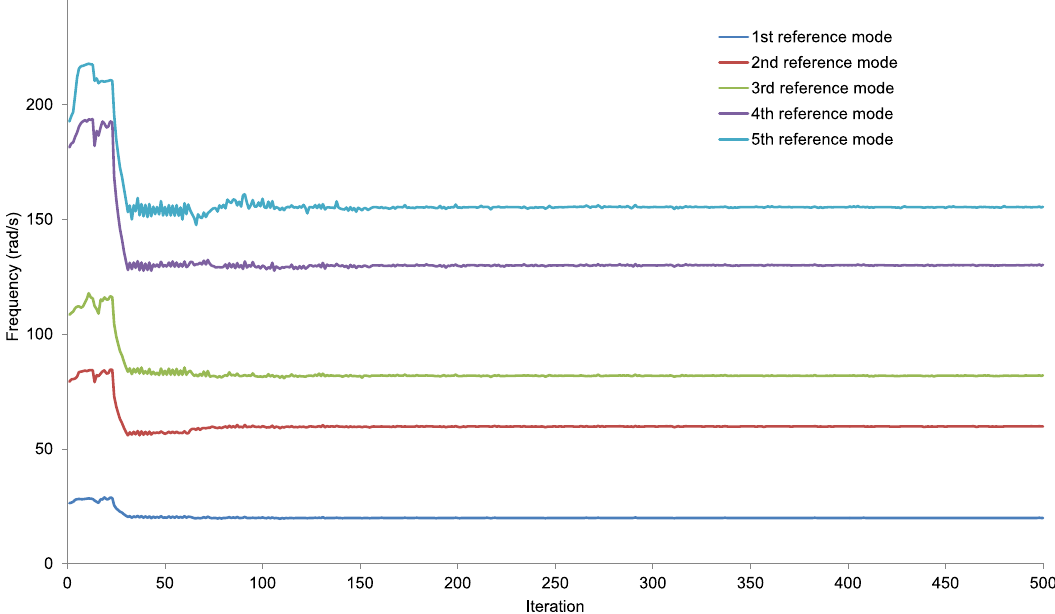
Fig. 5. Evolution of the natural frequencies of the current model sorted according the best corresponding reference modes. The frequencies of the 4th and 5th modes nearly intersect around iteration 40, however their values do not cross during the optimization process.